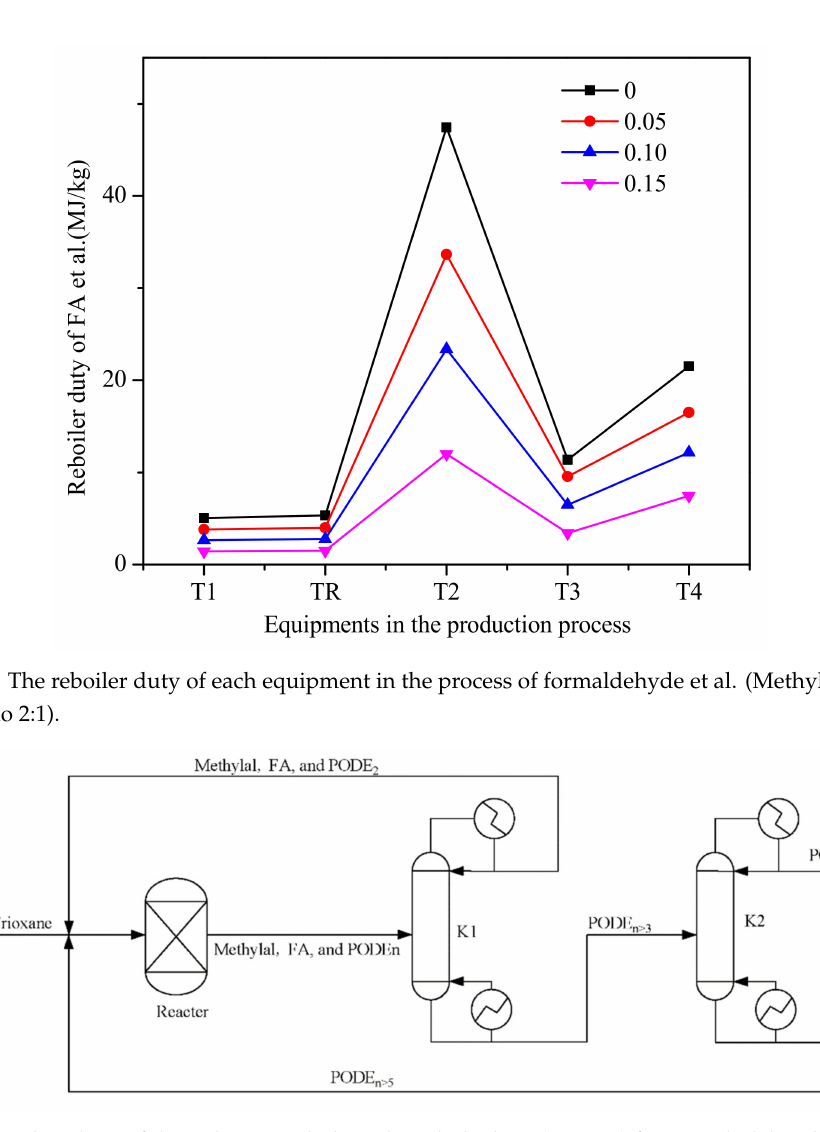
Figure 10. Flowsheet of the polyoxymethylene dimethyl ethers (PODE n ) from methylal and